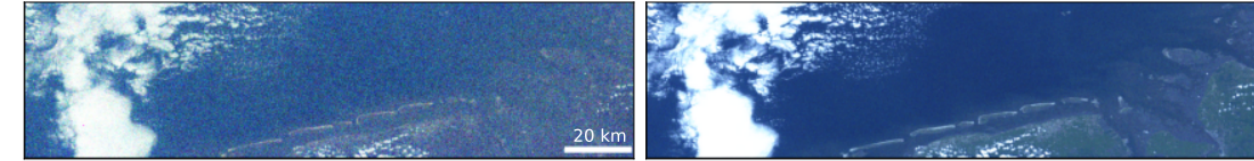
Figure 11. The Laguna San Rafael scene ( left ) and the second North Sea scene ( right ) clustered according to the SOM calculated on each, with the ( a , b ) column number and ( c , d ) row number. ( e , f ) the relative quantization error.